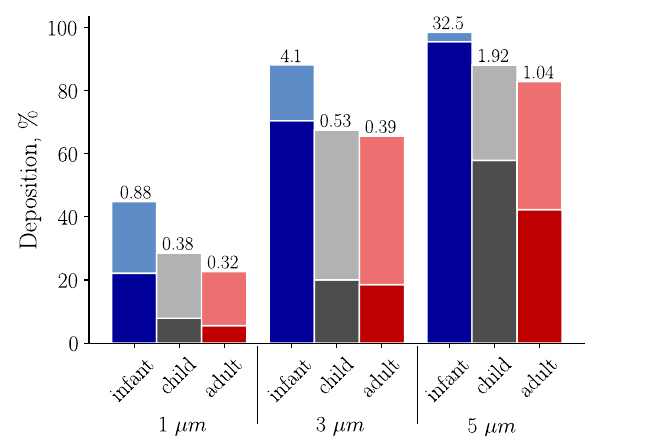
Table 2. Calculated whole lung dosimetry for the three age groups and particle sizes. d p particle diameter, the tidal volume and A FRC is the lung surface area at FRC, Table 1), rate of deposited particulate matter ( Dep T × TV × RR : where RR is the respiratory rate, Table 1), normalized by body surface area, BSA: Dep T × TV × RR Dep T × TV TV A ), conducting region tissue BSA , relative deposition percentages compared to the adult ( dose ( Dep C A ), and respiratory region tissue dose ( Dep R A ). R C